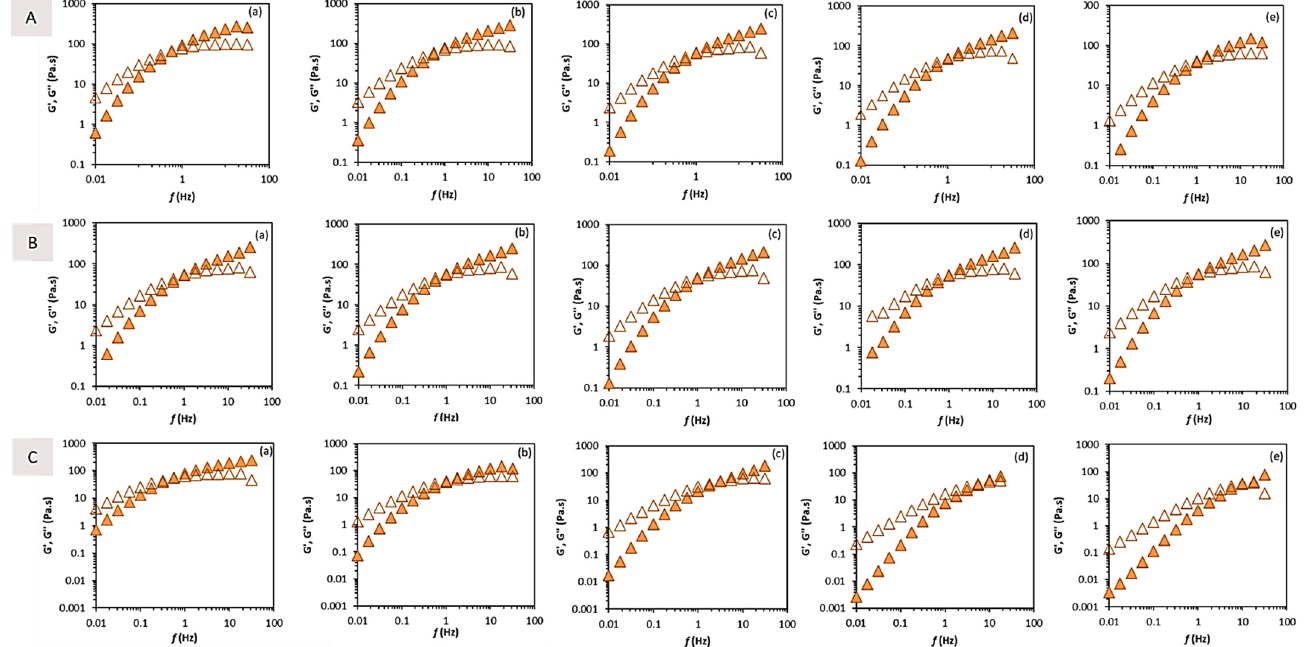
Figure 5. Mechanical spectra for d-FucoPol. ( A ) Ionic strength (NaCL) effect: (a) 3 M, (b) 2 M, (c) 1 M, (d) 0.1 M, and (e) 0.5 M. ( B ) pH: (a) 3.6, (b) 4.8, ( c ) 6.2, (d) 8.5, and (e) 11.5. ( C ) Temperature effect: (a) 10 °C, (b) 25 °C, (c) 45 °C, (d) 65 °C, and € 80 °C. Elastic G’ (closed) and viscous G” (open) moduli.